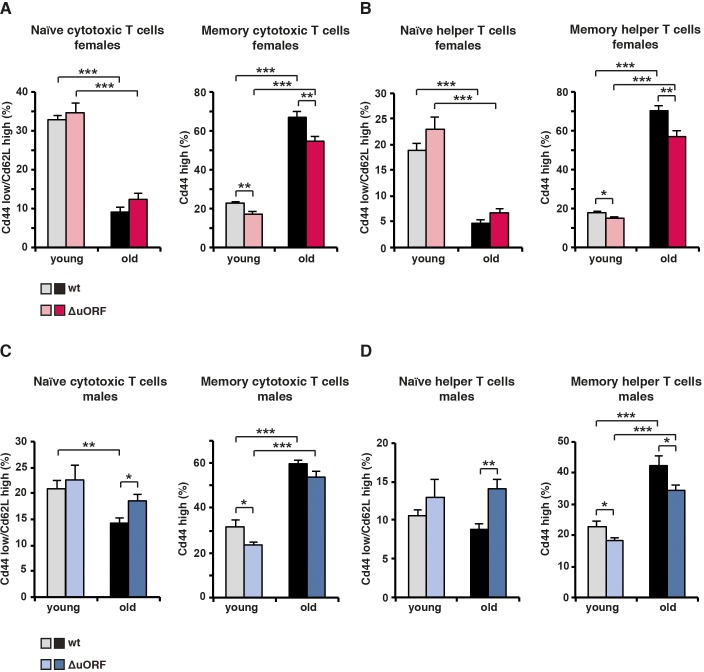
Analysis of memory / naïve T-cell ratios of cytotoxic and helper T-cells in young and old mice.(A) At the left, for females the percentage naïve cytotoxic T cells (Cd44low/Cd62Lhigh) in respect to the total amount of cytotoxic T cells (Cd8+); at the right, percentage of memory (Cd44high) cytotoxic T cells in respect to the total amount of cytotoxic (Cd8+) T cells. (B) At the left, for females the percentage naïve helper T cells (Cd44low/Cd62Lhigh) in respect to the total amount of helper T cells (Cd4+); at the right percentage memory T cells (Cd44high) in respect to the total amount of helper T cells (Cd4+). (C) The same analysis as in (A) for males. (D) The same analysis as in (B) for males. (wt females, n=10 young, n=12 old; wt males, n=12 young and old; C/EBPβΔuORFfemales, n=10 young, n=12 old; C/EBPβΔuORFmales, n=12 young and old). P-values were determined by Student’s t-test, *p<0.05; **p<0.01; ***p<0.001.